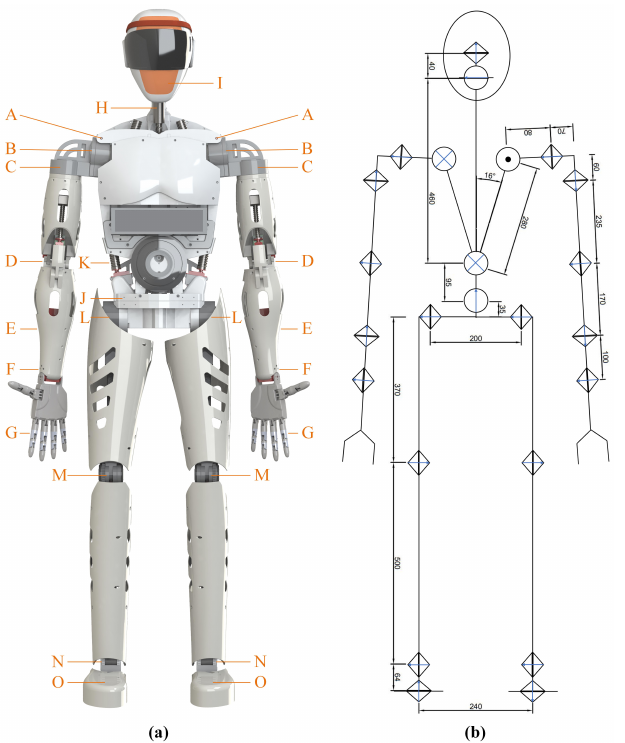
Figure 2. Overview of ( a ) Taikobot’s appearance, joint configuration and ( b ) dimensions in mm. Joint indexes are the same as in Table